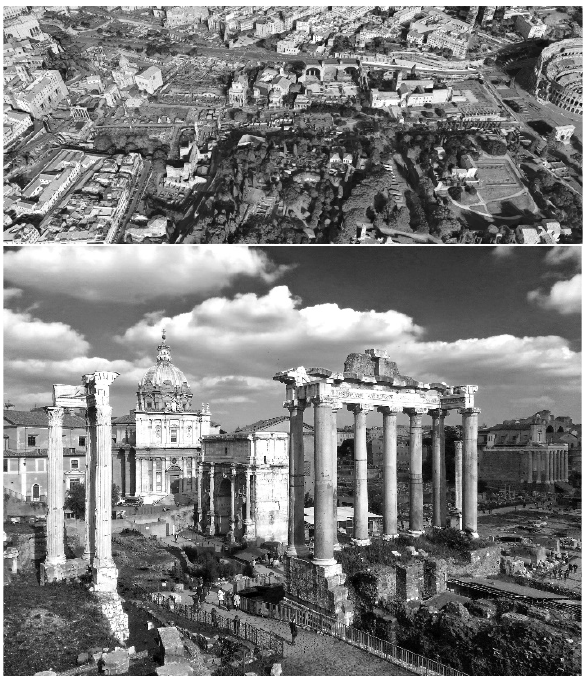
Figure 3: Aerial view of the Roman Forum which highlights the vastness of the central archaeological area. View of the Roman Forum on the side of the